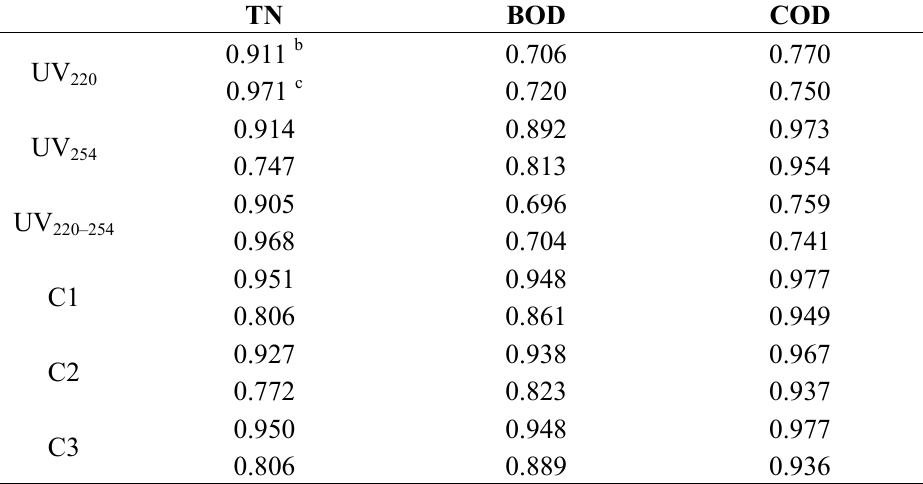
Table 3. Correlation coefficients a (Pearson r values and spearman rho values) between selected spectroscopic indices and some water quality parameters (n =